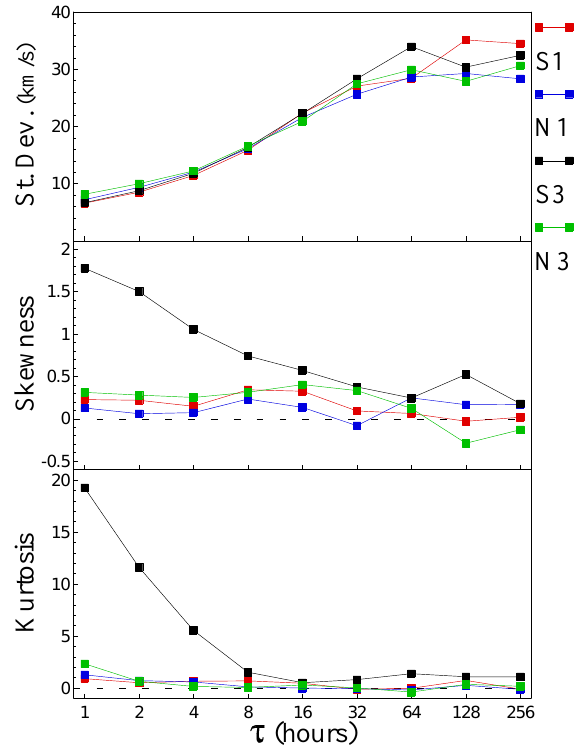
Fig. 4. From top to bottom: wind velocity V and velocity differ- ences δV 0, δV 1, δV 2, δV 5, δV 8 for the polar wind sample S3. Three sharp changes in V (labeled as A, B, and C) cause spikes in velocity differences at small scales (arrows point to V changes and δV 0